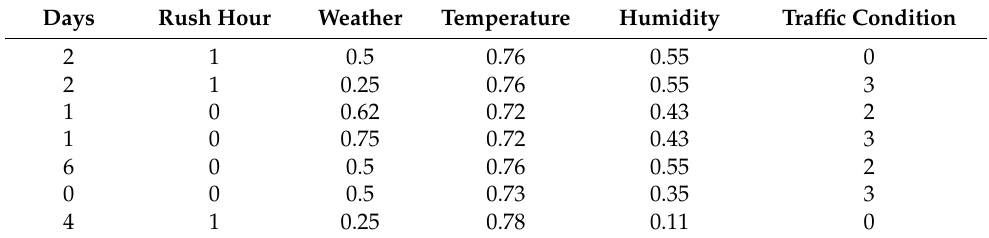
Table 19. The dataset collection result for Menado2-GudangUtara4 road